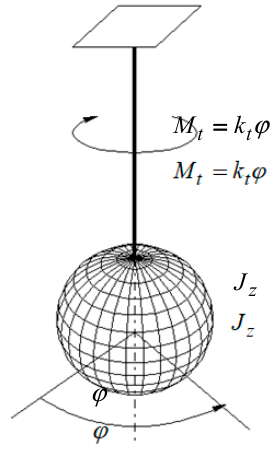
Figure A1. By denoting the torsional rigidity of the wire k t , when the pendulum rotates with a φ angle with respect to the equilibrium position, the wire is subjected to the moment of torsion M t =k t φ that opposes the torsion of the wire.